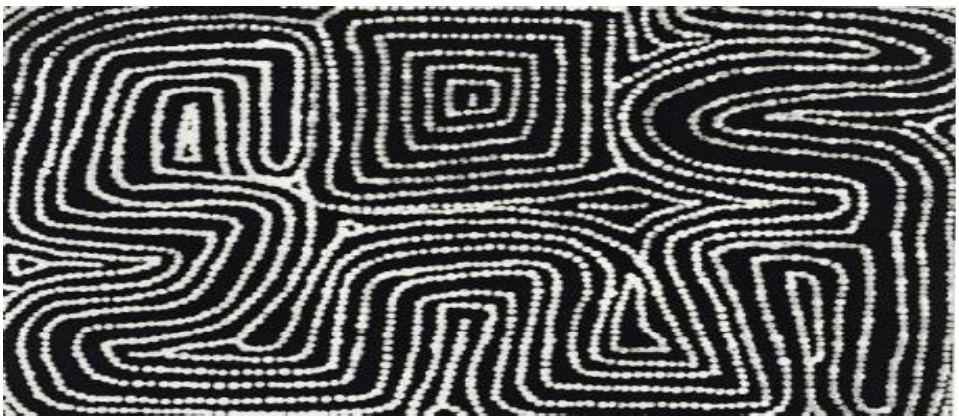
Figure 6. Warlimpirrnga Tjapaltjarri, Marrawa, Tjukurrpa Palurukutu, Kutjupawana Palyantjanya. Same Stories, A New Way, 2009. © Warlimpirrnga Tjapaltjarri. Licensed by Aboriginal Artists Agency Ltd.